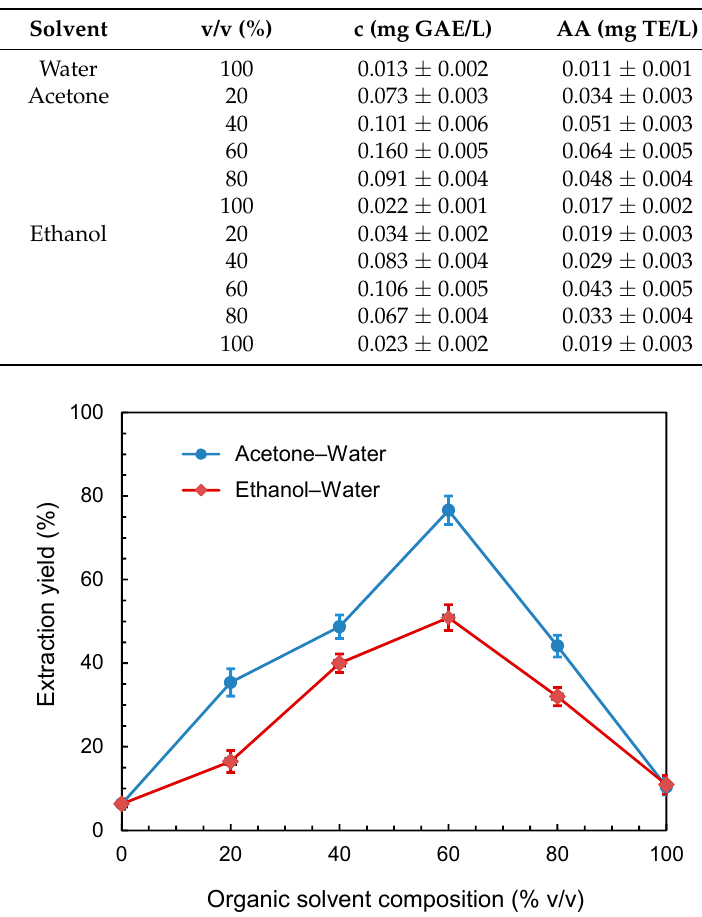
Figure 2. Percent phenolic extraction yields in water–organic solvent